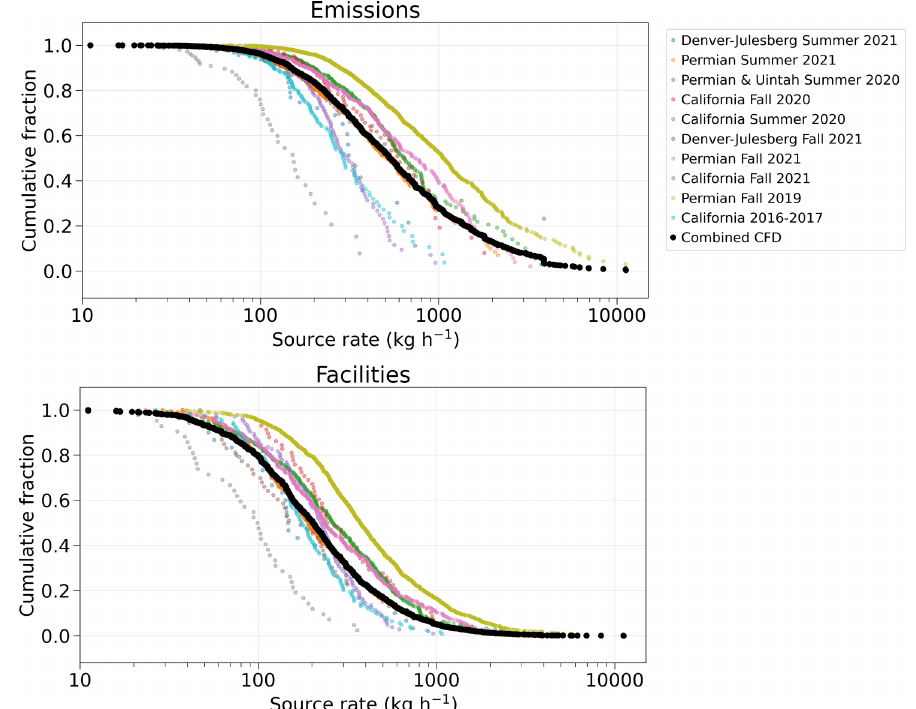
Figure 7. Cumulative frequency distributions (CFDs) of point source rates above 10kgh − 1 for 3879 point sources detected by airborne remote sensing in California and in US oil and gas basins by Duren et al. (2019) and Cusworth et al. (2022). Many of the individual point sources were detected multiple times, and the values entered in the frequency distributions are the averages of these detections not including non-detection events; they thus represent the average emission from the source when on, as is relevant to the definition of the instrument detection threshold C D in Eq. (8). The colored curves are for individual campaigns, and the black curve is the combined CFD for all regions with equal weighting per campaign. The top panel gives the cumulative fraction of emissions contributed by detected point sources above a given rate, and the bottom panel gives the cumulative fraction of the number of point sources. For example, a satellite instrument with detection threshold of 100kgh − 1 could detect 80% of the point sources in the combined CFD, contributing 95% of total point source emissions. An instrument with detection threshold of 1000kgh − 1 could detect 5% of the point sources in the combined CFD, contributing 30% of total point source